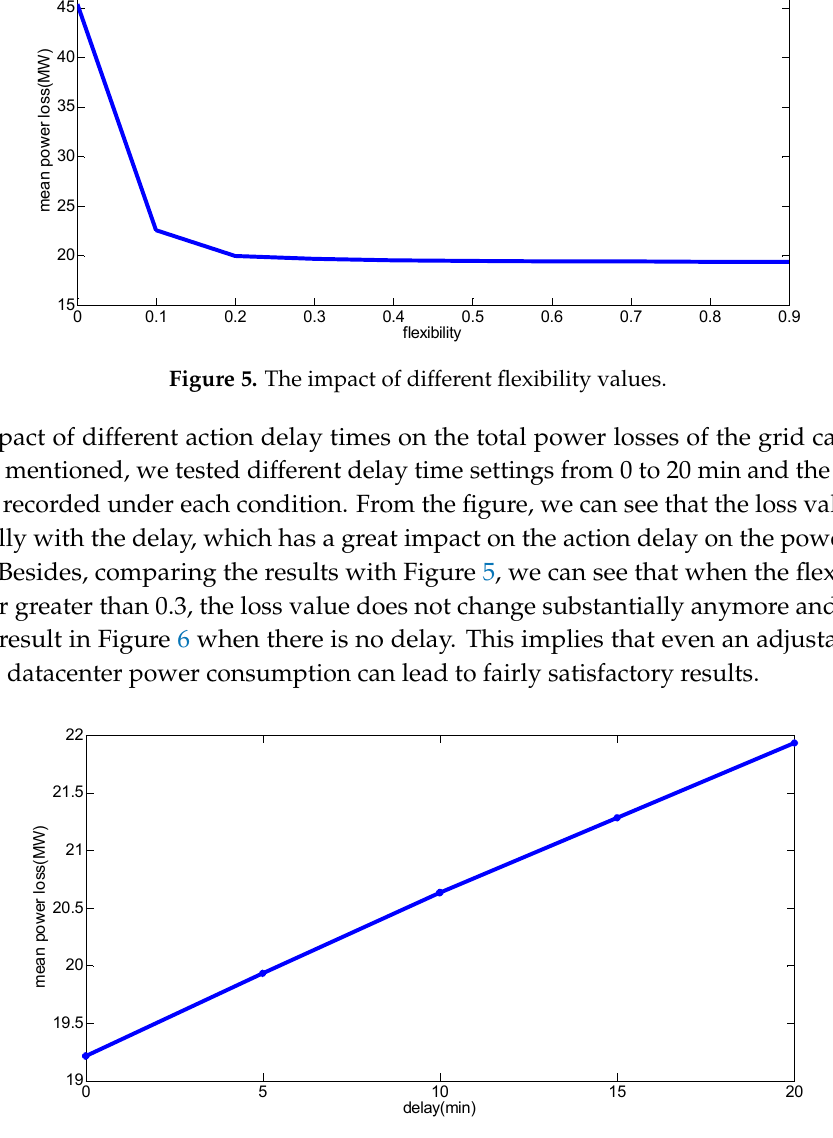
Figure 6. The impact of datacenter action delays.